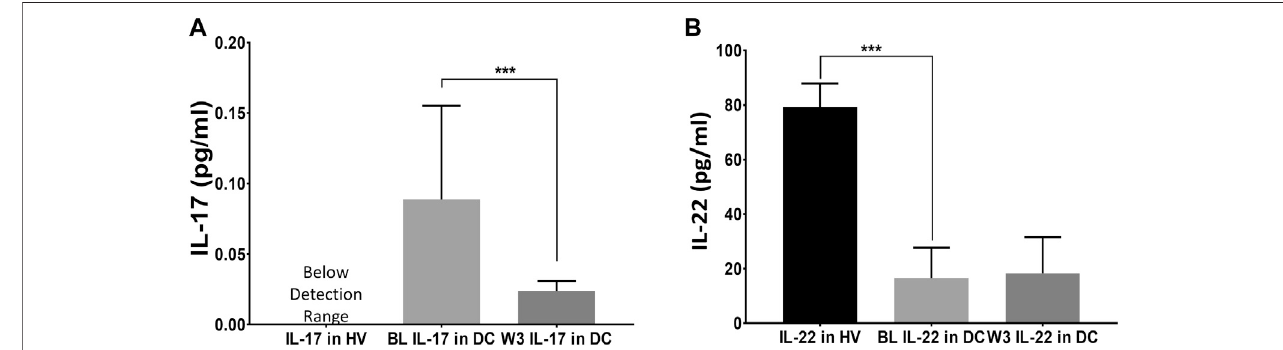
FIGURE1| Ef fi cacyofthiaminetreatmentonTh17cellderivedresponseforIL-17,andIL-22cytokines.LevelsofIL-17andIL-22inhealthyvolunteers(HV)atbaseline; andDiseaseControls[DCor(alcoholusedisorder,AUD)]patientsexhibitingaproin fl ammatoryresponse( n (cid:1) 16)atbaseline;andanti-in fl ammatorynormalizationofcytokines testedafterthecompletionofthree-week(W3)thiaminetreatment.AdropinIL-17 (A) coupledwithamildincreaseinIL-22 (B) atW3wasobservedcomparedtothebaseline levels. BL: baseline, W3: three-week of thiamine treatment. Data are presented as M ± SD. Statistical signi fi cance was set as p <